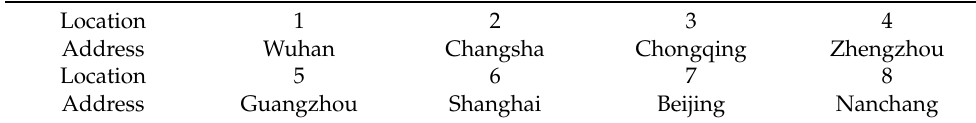
Table 2. The basic information of the corresponding city. Location